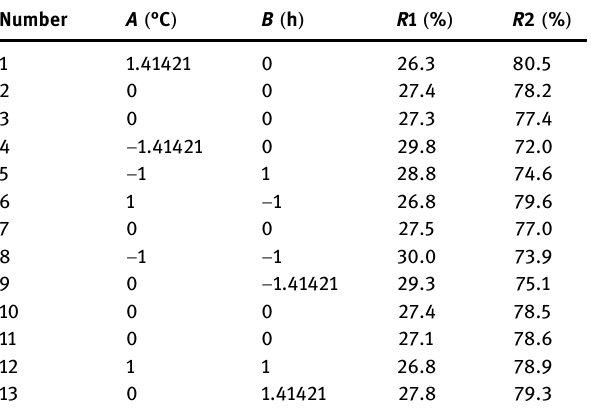
Table 3: Test scheme and results of